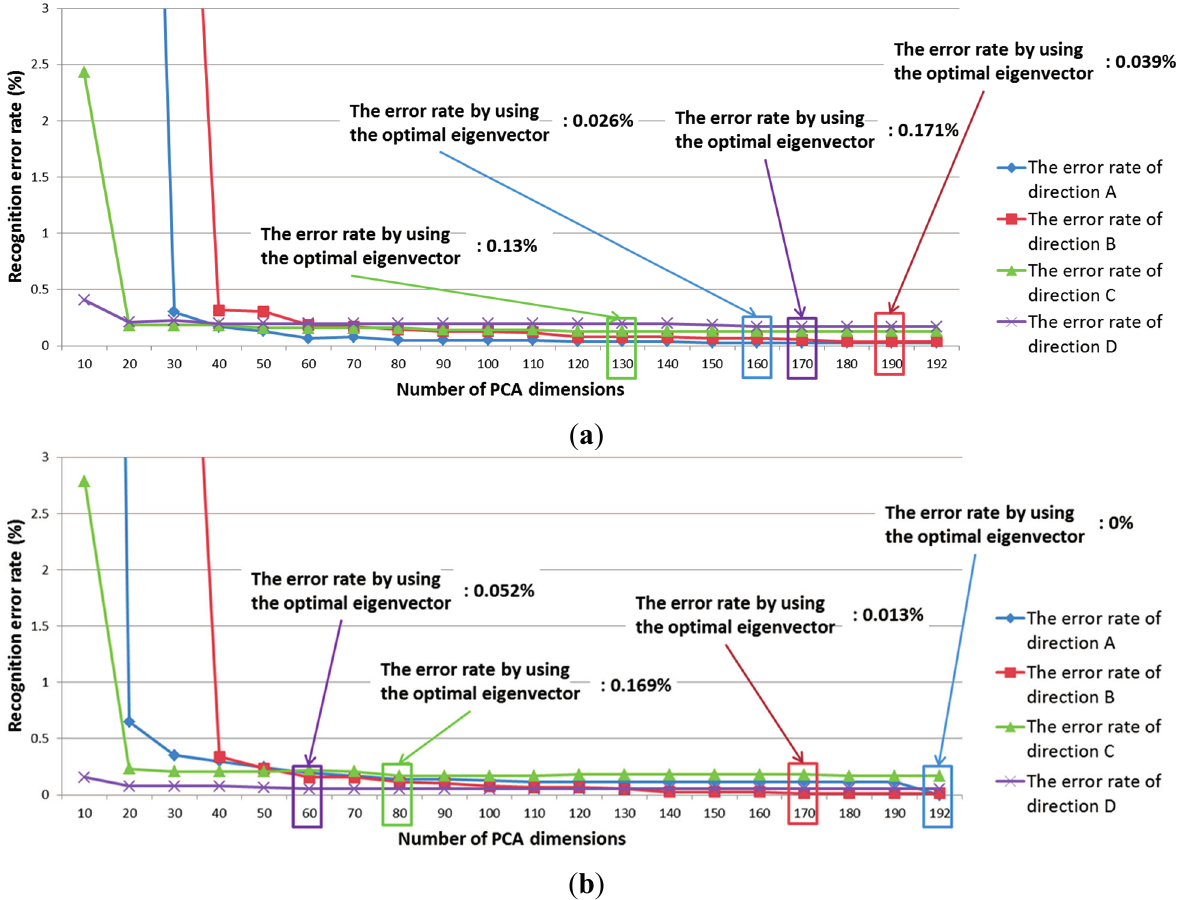
Figure 8. Recognition results for training data using the K-means method: ( a ) Group 1; ( b ) Group